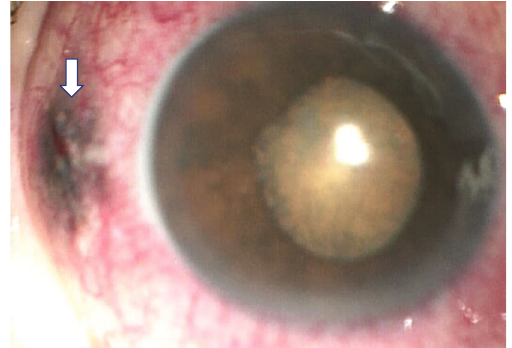
Figure 2: Showing conjunctival bluish black pigmentation of the conjunctiva (Arrow) in the superotemporal quadrant in the left